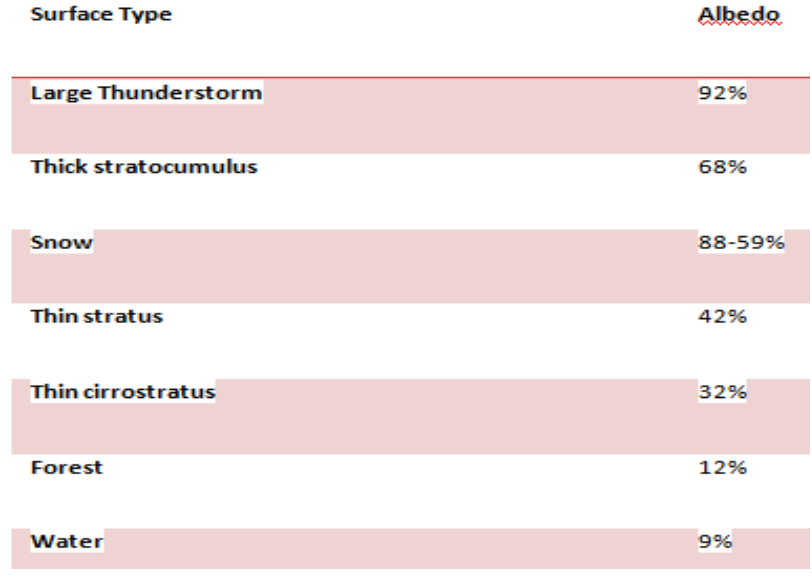
Table 3: The albedo for different surface type